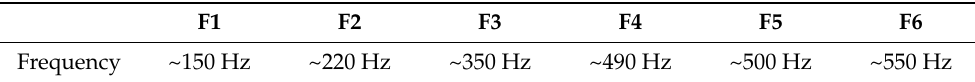
Table 3. Frequencies extracted from the two accelerometers on Days 1 and